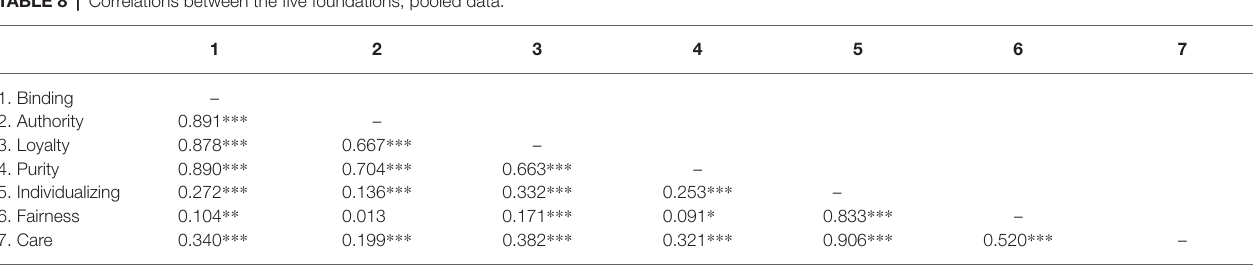
TABLE 8 | Correlations between the five foundations, pooled